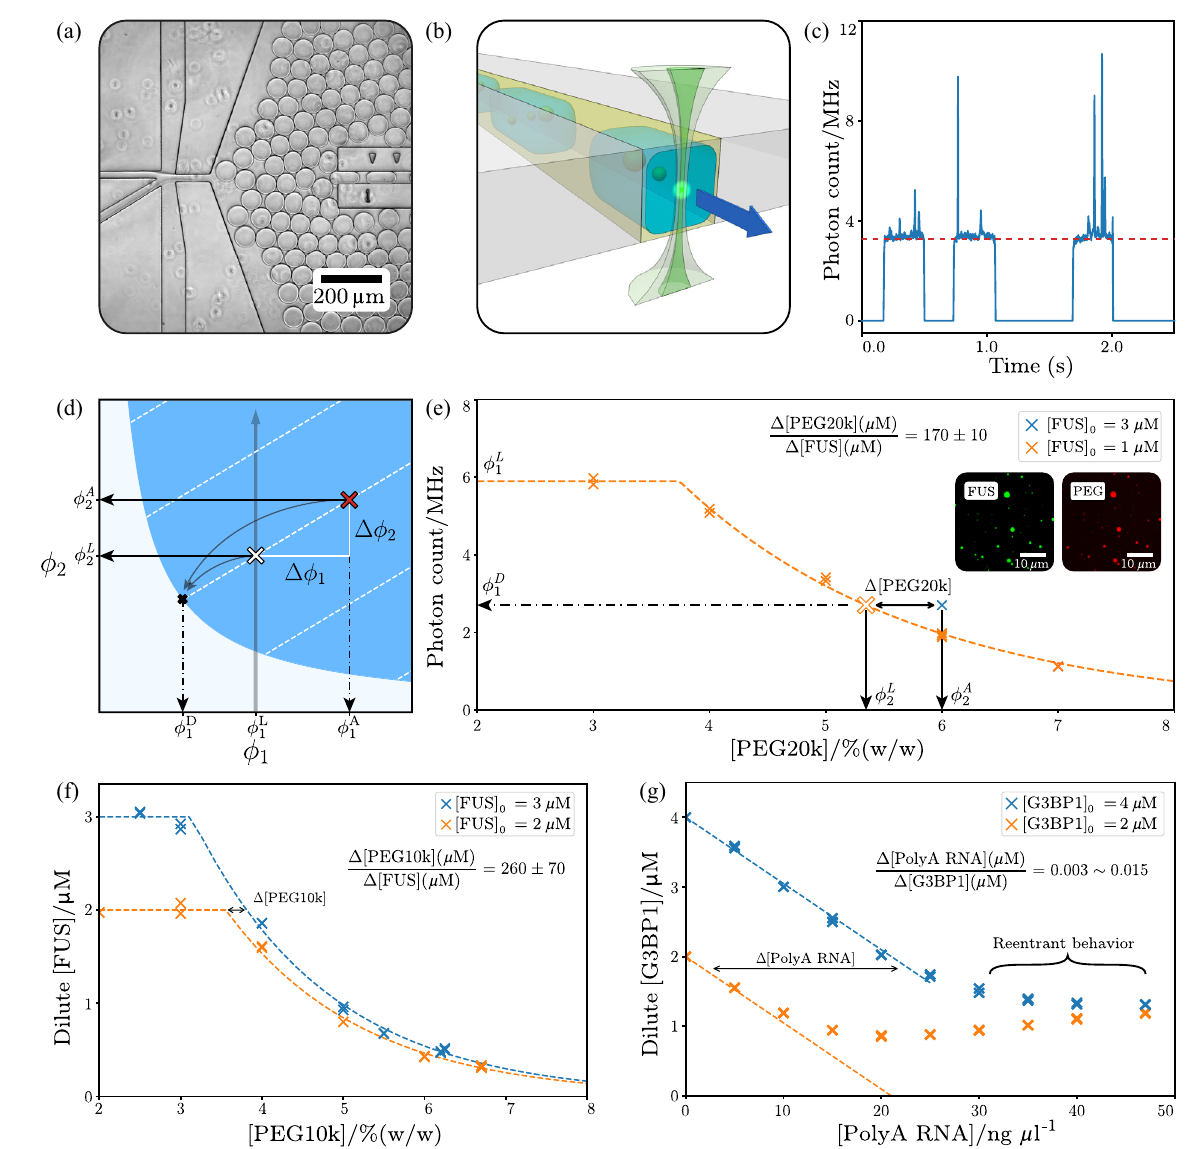
FIG. 3. Experimental determination of tie lines through measurements of the dilute phase concentrations. (a) Bright-field-microscopy image of the microfluidic device. Droplets are generated on the left and pushed into a narrow channel on the right. Measurements are performed at the end of the channel to allow sufficient incubation time. (b) 3D illustration of the channel cross section and the confocal profile. (c) Raw signal coming from three droplets (blue solid line) characterized by plateaus from dilute phase readings and spikes from condensates passing through the confocal spot. During analysis, a 3 σ cutoff is used to filter out the spikes to give an estimate of the dilute phase photon count averaged over approximately 100 droplets (red dashed line). Regions of low photon counts are gaps between droplets. (d) Illustration of anchored linescan. Blue region is the binodal with representative tie lines (white dashed lines). The anchor is plotted as a red cross and linescan plotted as a vertical gray solid line. By comparing the dilute phase ϕ 1 concentrations ( ϕ D 1 ), one identifies from the linescan the second point on the tie line (white cross). The gradient can then be calculated as k ¼ ð Δ ϕ 2 = Δ ϕ 1 Þ . (e) Results of anchored linescan for the FUS-PEG20k system. Solid crosses are measured values and the hollow cross is interpolated. The dashed line is a phenomenological fit. Measurement errors are comparable to marker sizes. Inset: confocal microscopy images of condensates with both FUS and PEG20k labeled. (f) Serial linescans for the FUS-PEG10k system. Dashed lines are phenomenological fits. (g) Serial linescans for G3BP1-poly(A) RNA system showing an initial drop in dilute phase (G3BP1) due to phase separation and a rise at higher [poly(A) RNA] due to the reentrant effect. Dashed lines are linear low-[poly(A) RNA] fits. Legends in (e) – (g) give total starting protein concentrations in